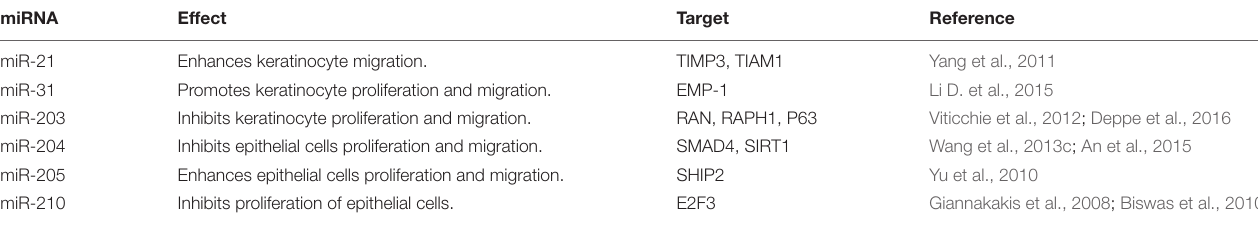
TABLE 1 | miRNAs involved in the re-epithelialization process in wound healing.